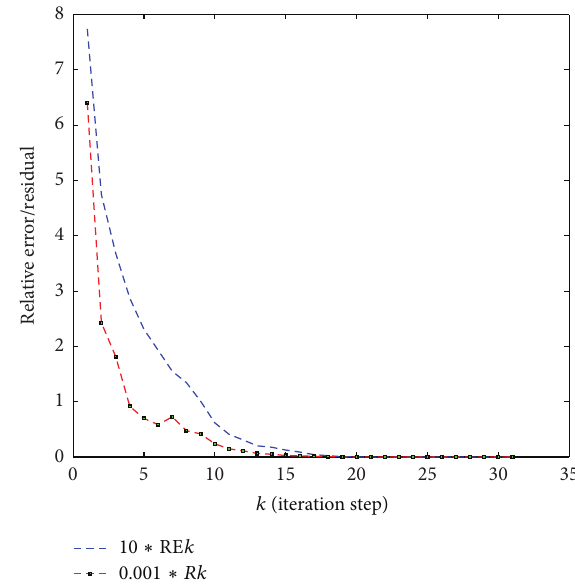
Figure 1: The relative error of the solutions and the residual for Example 10 with 𝑋 1 (1) = 0 and 𝑋 2 (1) = 0 .